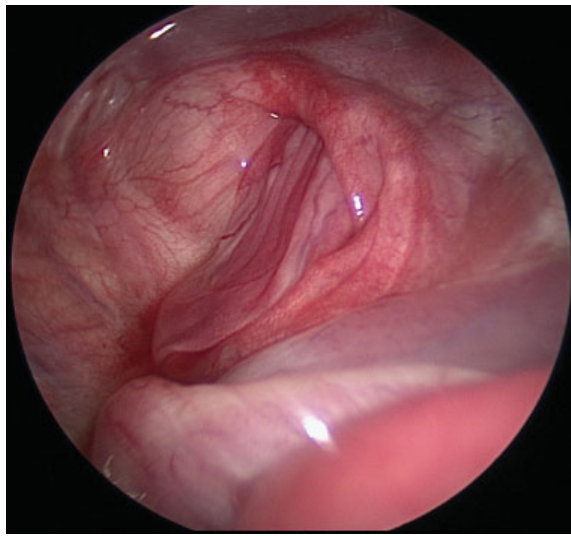
Fig. 2 Diaphragmatic defect after reduction of herniated structures.